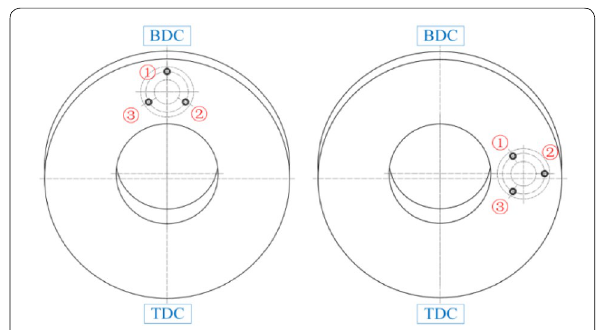
Figure 5 Two kinds of layout schemes of sensor mounting at the swash